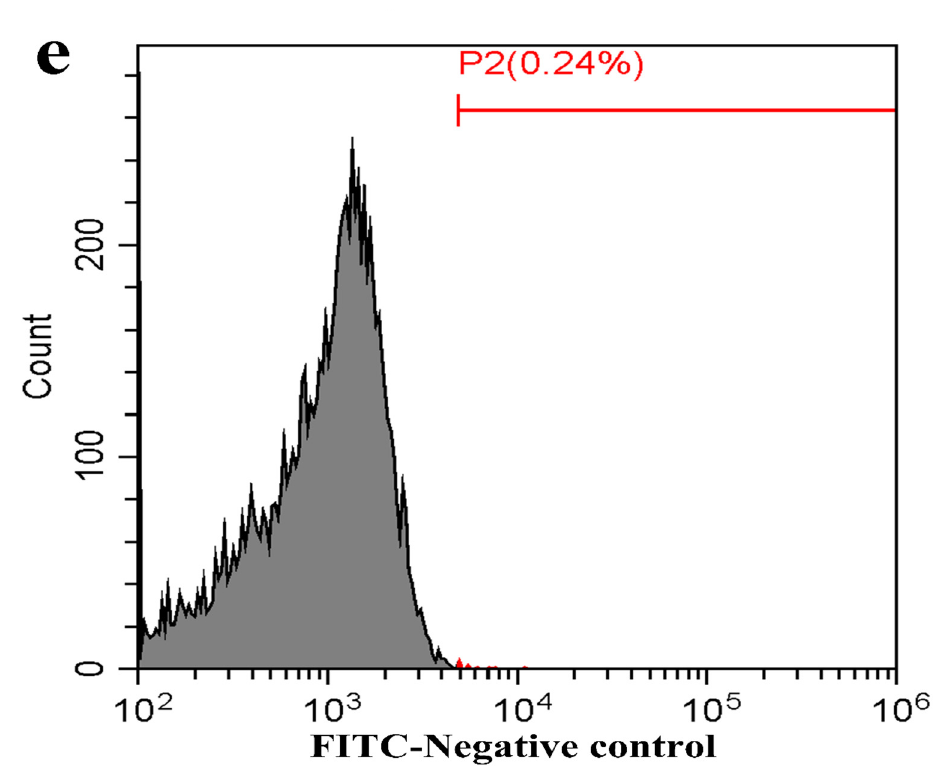
Figure 7. Flow cytometry analysis of Fc γ RI or Fc γ RIII on the surface of porcine AMs. The cells were transfected with Fc γ RI siRNA, Fc γ RIII siRNA or negative siRNA for 48 h. ( a ) Representative histograms of the percentage of negative siRNA-transfected cells surface-stained with anti-Fc γ RI IgG and FITC-conjugated goat anti-rabbit IgG. ( b ) Representative histograms of the percentage of Fc γ RI siRNA-transfected cells surface-stained with anti-Fc γ RI IgG and FITC-conjugated goat anti-rabbit IgG. ( c ) Representative histograms of the percentage of negative siRNA-transfected cells surface-stained with anti-Fc γ RIII IgG and FITC-conjugated goat anti-rabbit IgG. ( d ) Representative histograms of the percentage of Fc γ RIII siRNA-transfected cells surface-stained with anti-Fc γ RIII IgG and FITC-conjugated goat anti-rabbit IgG. ( e ) Representative histograms of the percentage of mock cells surface-stained with RNI and FITC-conjugated goat anti-rabbit IgG. Note: siRNA: small interfering RNA; Fc γ RI: Fc gamma receptor I; Fc γ RIII: Fc gamma receptor III; FITC: fluorescein isothiocyanate; RNI: rabbit-negative IgG.